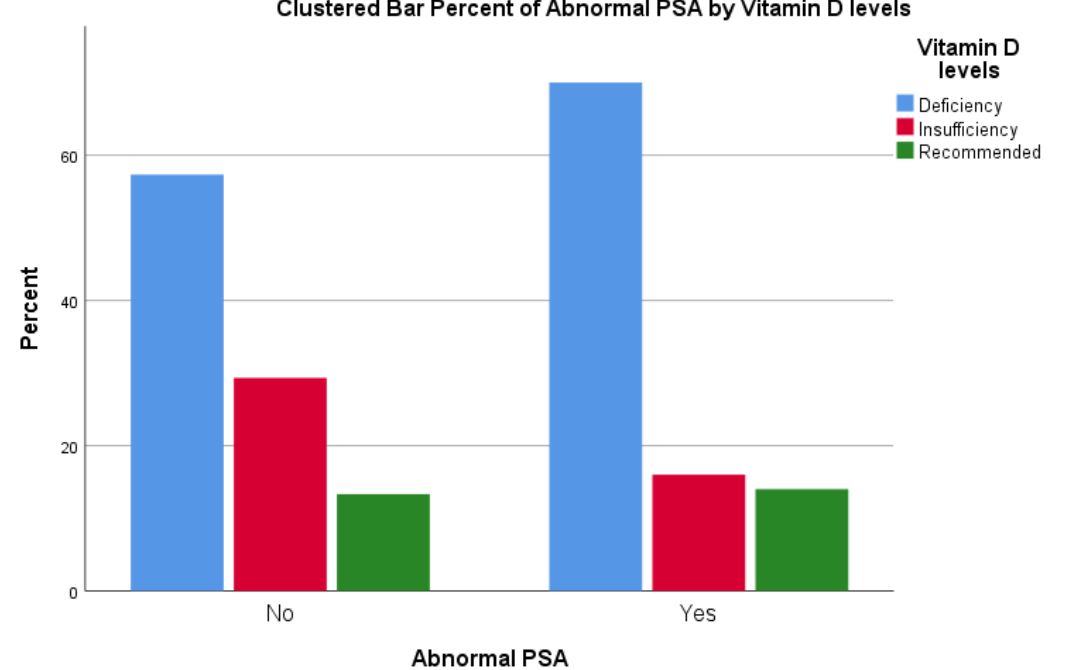
Figure 1. Distribution of vitamin D levels according to normal/abnormal PSA.